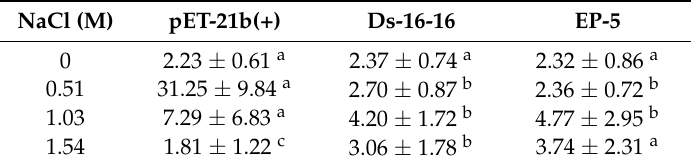
Table 1. The cell length of E . coli transformants expressing Ds-26-16 or EP-5 under NaCl conditions ( µ m).